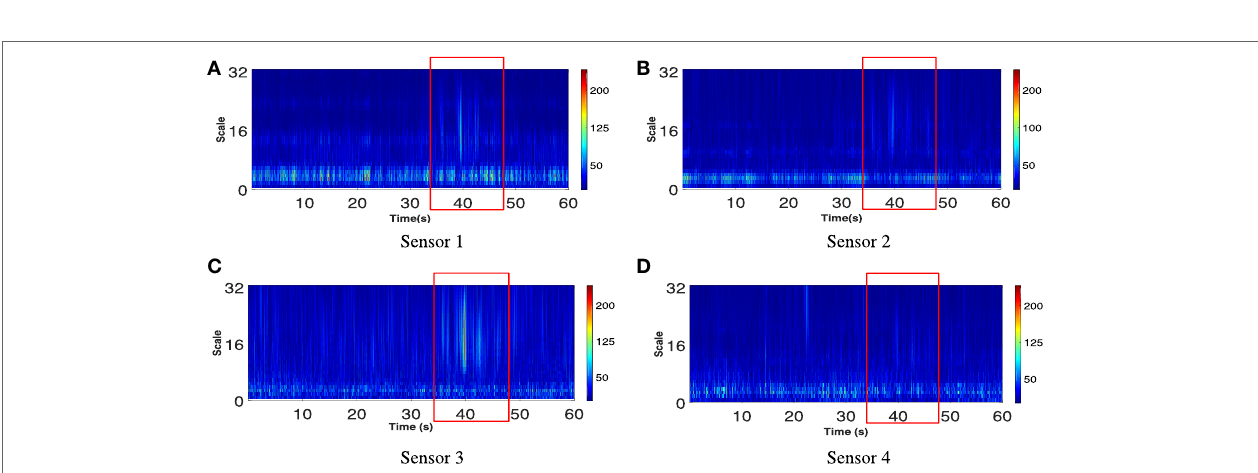
FIGURE 6 | Wavelet coefficients (scaled from 1 to 32) of the building vibration signals shown in Figure 4 . The red boxes show the time duration of train passing. The train event is clearly visible in the data from all four sensors between 38 and 45s. (A) Sensor 1. (B) Sensor 2. (C) Sensor 3. (D) Sensor 4.